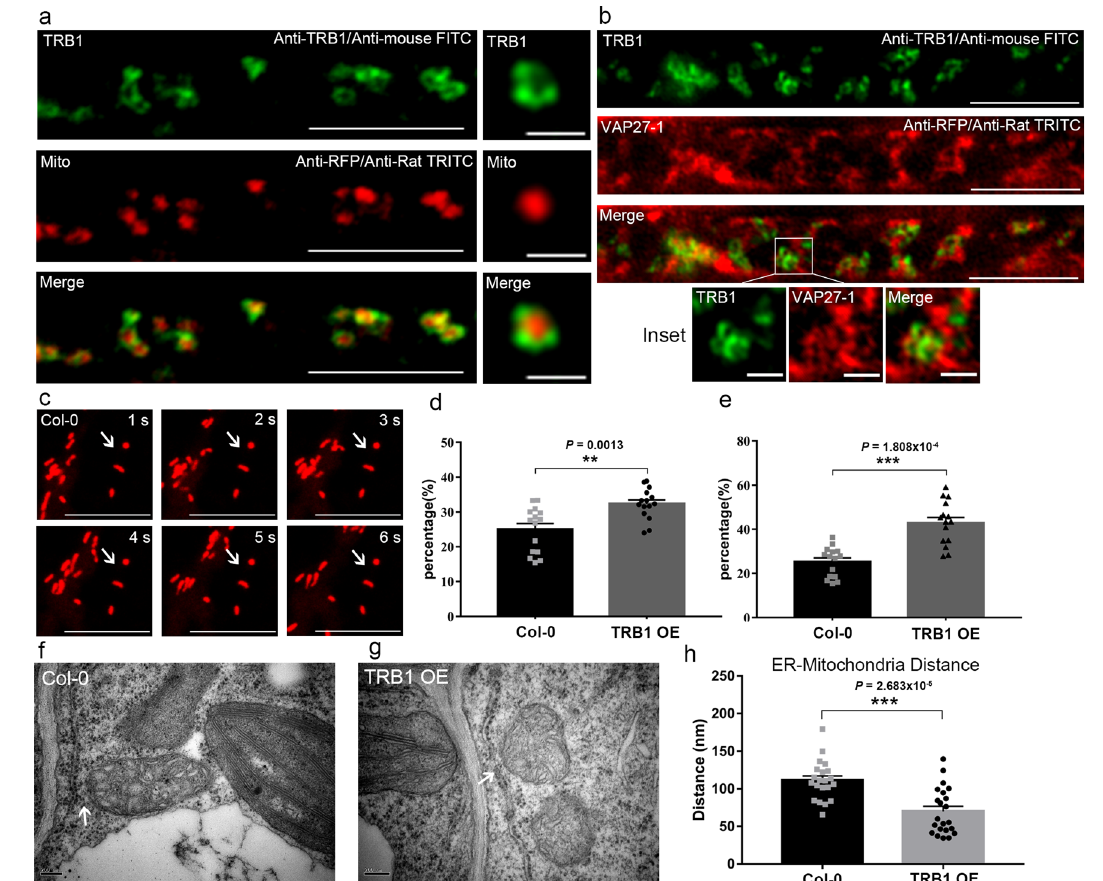
Fig. 3 | TRB1 protein is essential for mitochondrial movement and ER asso- ciation. a , b Arabidopsis expressing Mito-mCherry and VAP27-RFP was immuno- labelled with a TRB1 antibody; the endogenous protein localized at the outer mitochondrial membrane, and in contact with VAP27-labelled ER membrane, respectively. c An example of stationary mitochondria (arrow) that stay immobile during the sixsecond time course. d , e The percentage ofstationary mitochondria (immobile for at least six seconds) increased signi fi cantly in the presence of GFP- TRB1 or VAP27-1. TEM study of wild type Arabidopsis ( f ) and stable Arabidopsis transformed with GFP-TRB1 ( g ), the distance between ER and mitochondria is